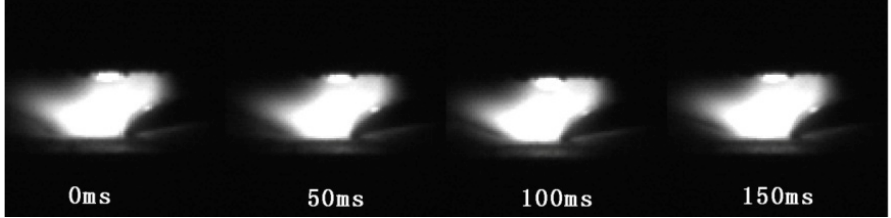
Figure 3. Metal transfer type when the distance between the wire tips and work pieces is 1 mm.